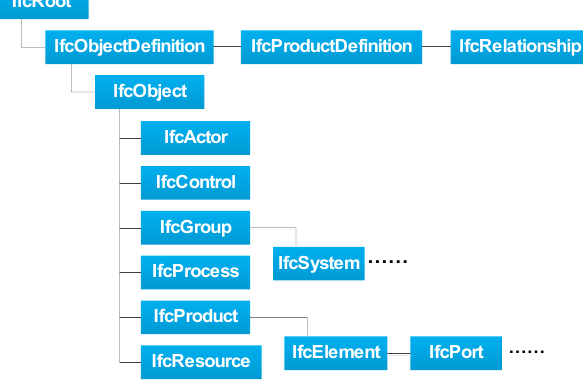
Figure 1. Entity inheritance.